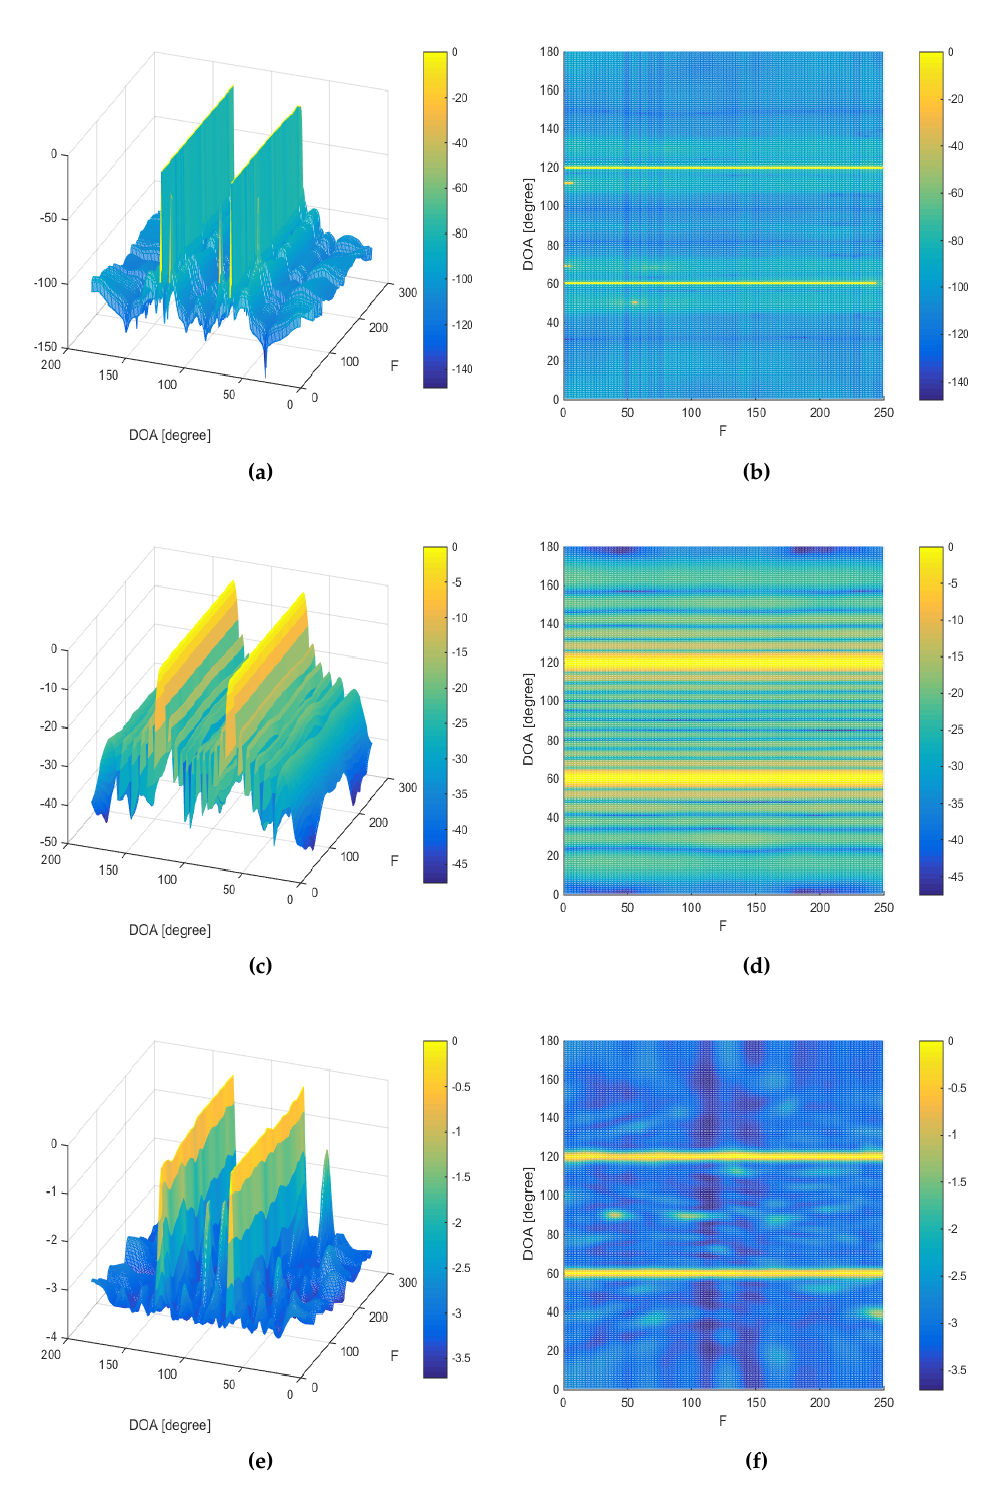
Figure 21. Wideband DOA estimation, two chirp source signals at DOAs 60 ◦ and 120 ◦ , γ = 0.5, 10 snapshots, using ULA containing 23 sensors for conventional beamforming and MUSIC algorithm. ( a , b ) The MVDR A-LASSO algorithm (after the first iteration); ( c , d ) Conventional beamforming; and ( e , f ) the MUSIC